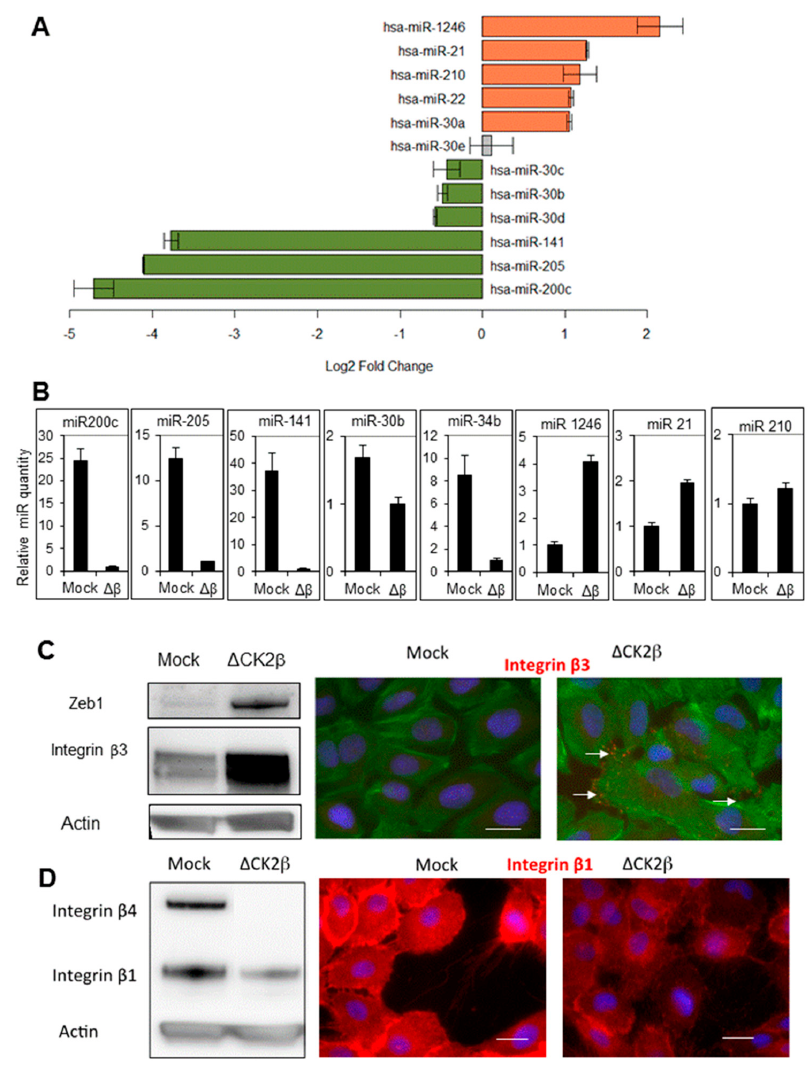
Figure 1. Modulation of miRNAs in Δ CK2 β -MCF10A cells. ( A ) Log2 fold change of the main miRNAs modulated in CK2 β -depleted versus parental MCF10A cells measured by miRNA array analysis; ( B ) Changes of miRNA expression between CK2 β -depleted and Mock-MCF10A cells were confirmed by using the indicated TaqMan probes. The relative amount of each miRNAs was determined by cross-normalization to Δ CK2 β samples using the comparative method and miR-720 as an internal reference; ( C ) Two targets of miR-200 and miR-30 families, respectively Zeb1 and integrin β 3, were analyzed by Western blot and/or immunofluorescence in Mock- and CK2 β -depleted cells. The ratio ∆ CK2 β /Mock of signal intensity in western blot was determined (3.5 and 2.3 for Zeb1 and integrin β 3 respectively). Arrows indicate integrin β 3 localization; ( D ) Integrin β 1 and β 4, targets of miR-21 were analyzed by western blot and/or immunofluorescence in Mock- and CK2 β -depleted cells. The ratio ∆ CK2 β /Mock of signal intensity in western blot was 0.4 for integrin β 1. F-actin in green, nuclei in blue, and integrin β in red. Scale bar, 10 µ